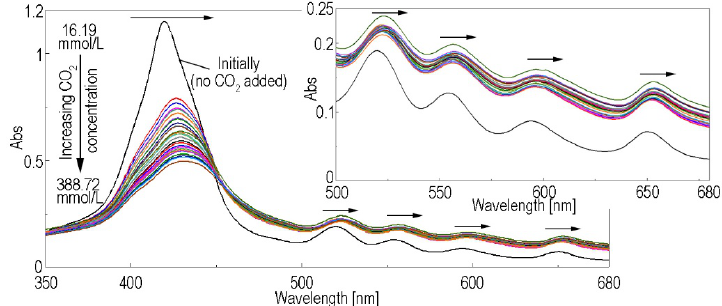
Figure 4. UV-Vis absorption spectra during CO 2 gas capture in the sol containing (5-COOH-3MPP)- k-carrageenan composite, in DMF:water = 2:3 ( v/v ) mixture. It can be observed that the accumulation of CO 2 in the sol leads to the bathochromic shift of the absorption maxima and also to a hypochromic effect. This shift to longer wave- lengths can be attributed to the slight protonation of the porphyrin molecules, as carbonic acid is accumulating in the mixture due to the presence of water in the system. The acid also causing the enlargement of the Soret band [11]. An isosbestic point at 453 nm is ob- served, marking both the generation of protonated porphyrins and the link between CO 2 and the - NH from internal ring of porphyrins. Figure 5 represents the linear dependence